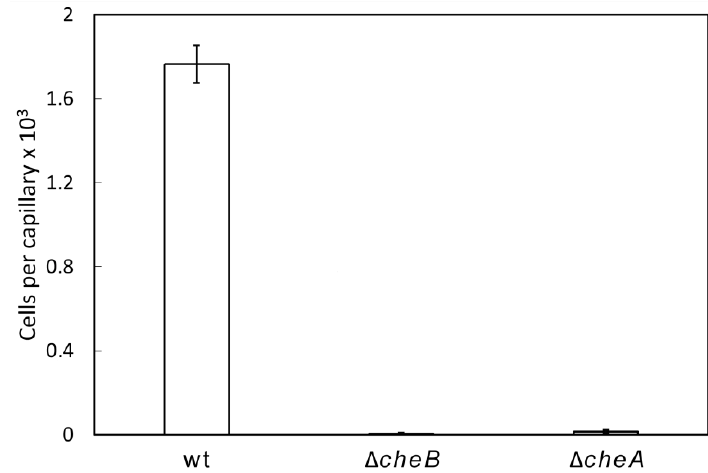
Figure 3. Quantitative capillary chemotaxis assays of wild-type and mutant strains of P. atrosepticum SCRI1043 towards 0.1% ( w / v ) casamino acids. Data were corrected with the bacteria that migrated into buffer-containing capillaries (225 ± 35). Data are means and standard deviations from three experiments conducted in triplicate. wt: wild-type.